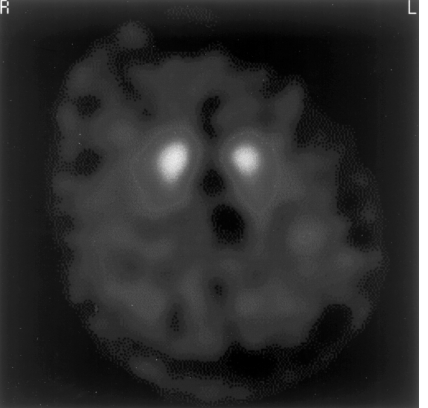
Fig. 4. SPECT image of [ 123 I]FP-CIT binding to dopamine transporters in a patient with MSA. Note the similarity between this image and the images of subjects with PD using the same tracer (Fig. 3) which complicates the differential diagnosis (image courtesy of Dr. Jim Patterson, Institute of Neurological Sciences, Glasgow).